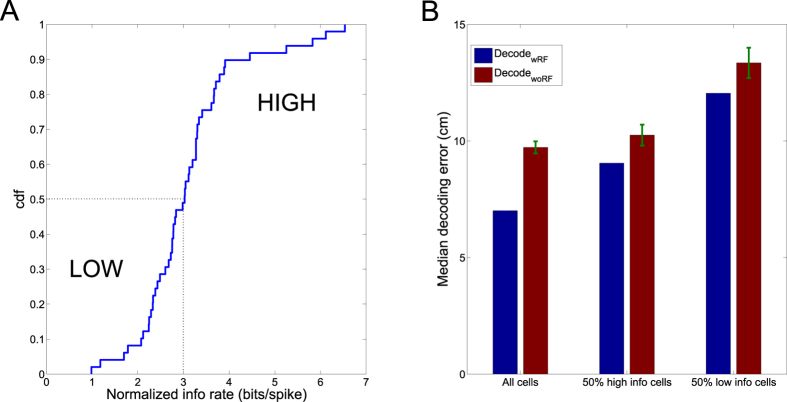
Specificity of hippocampal neurons in cell population on the decoding error.(A) Cumulative distribution of normalized spatial information rate (bits/spike) of 49 hippocampal neurons (Dataset 1). (B) Comparison of median decoding error by using spatial-information high vs. low subpopulations (T0 = 10 bpe, ρ = 0.5; error bar denotes SEM, n = 50 Monte Carlo runs).